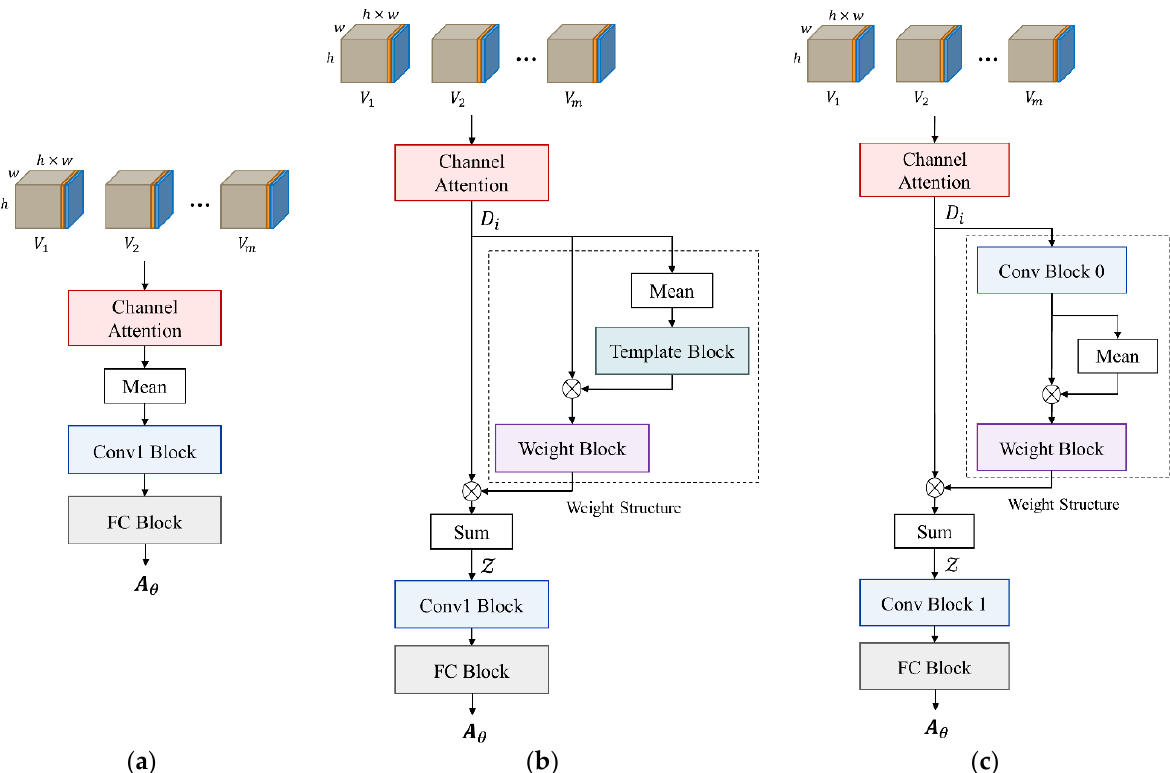
Figure 7. Architecture of regression head. Inputs are the feature blocks 𝑉 of the sub-image pairs. ( a ) is the basic architecture, ( b ) and ( c ) are the structure A and B respectively. Weight blocks generate the weight distribution 𝛂 for 𝑉 . Table 2. The layers in each block of regression head. Each row denotes a convolutional layer (size, kernels) with a default stride of 1 and padding of 0, followed by rectified linear units (ReLU). Block Output Setting Channel Attention